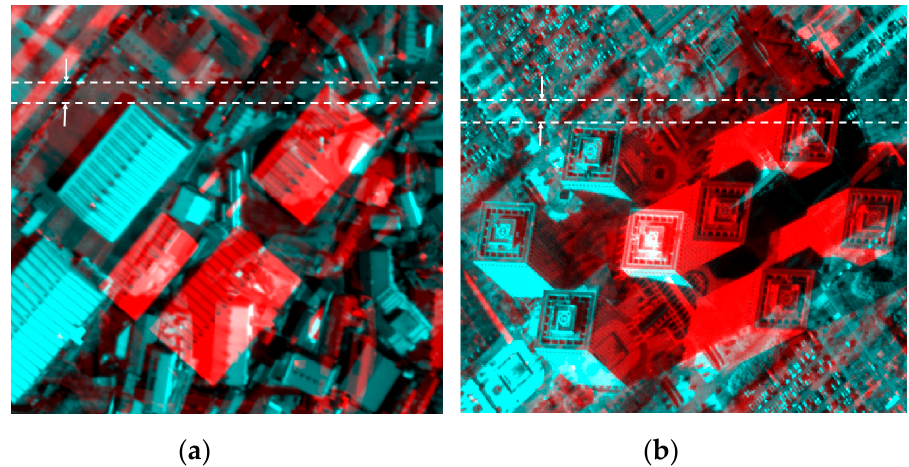
Figure 7. Y-parallax in the coarse epipolar resampled images: ( a ) along-track Kompsat-3 epipolar and ( b ) across-track Kompsat-3A epipolar.